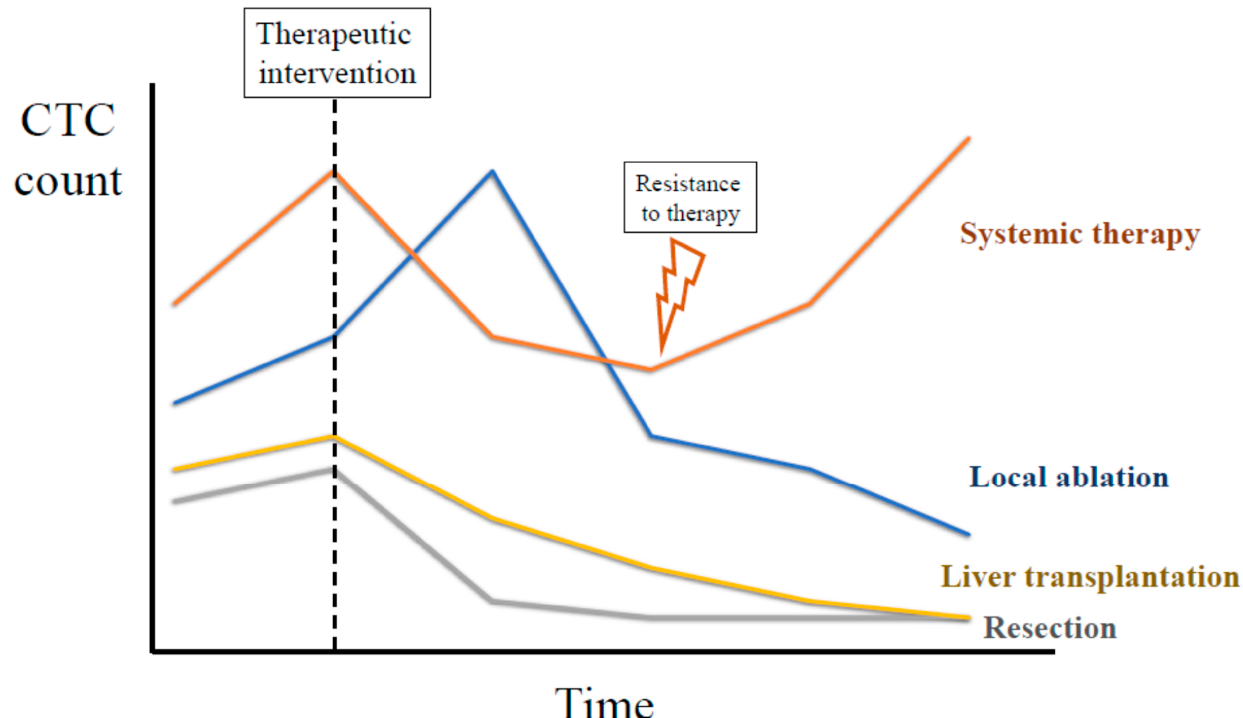
Figure 2. Illustration depicting the theoretical dynamics of circulating tumor cells after different successful therapeutic interventions.